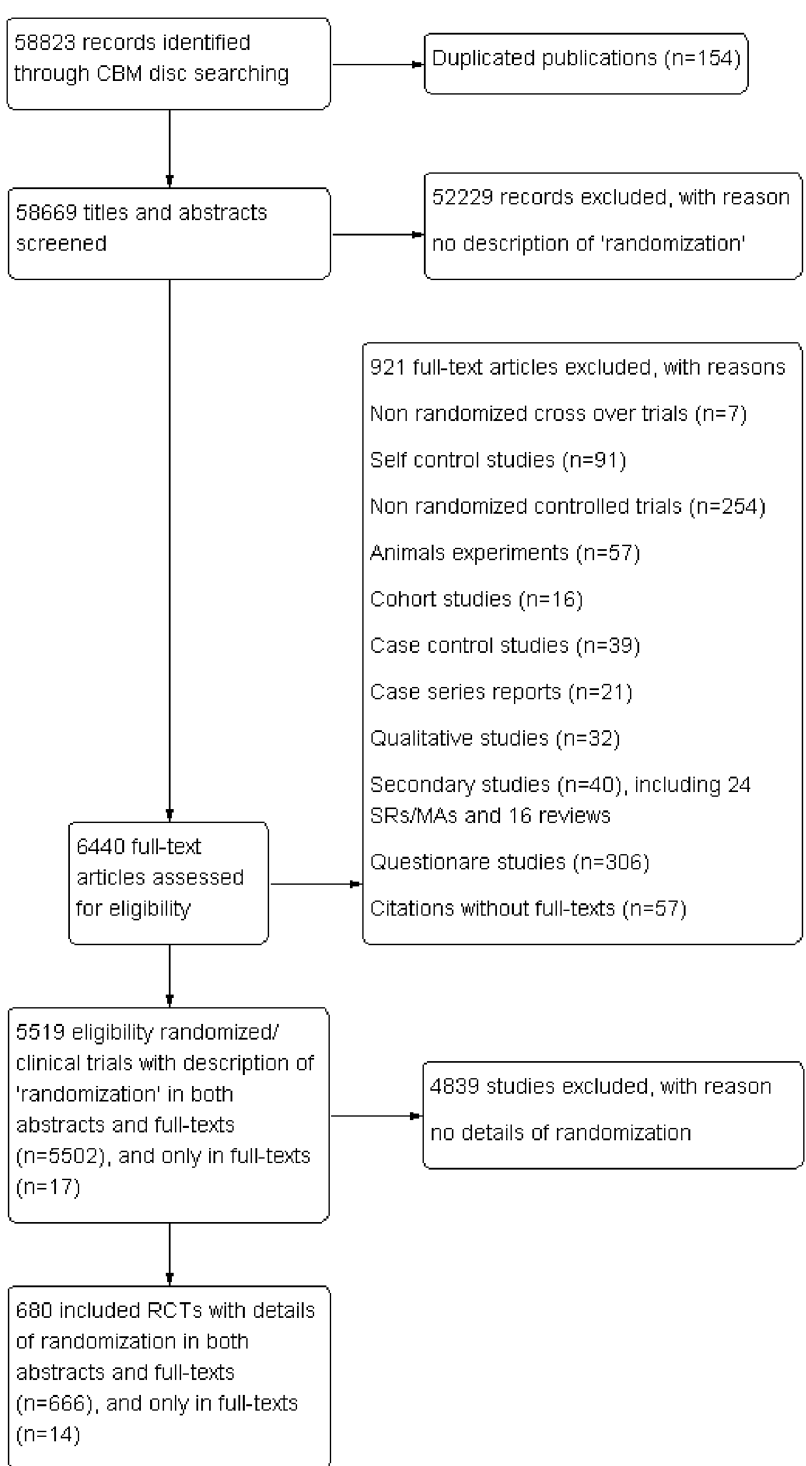
Figure 1. Flow diagram of included studies.